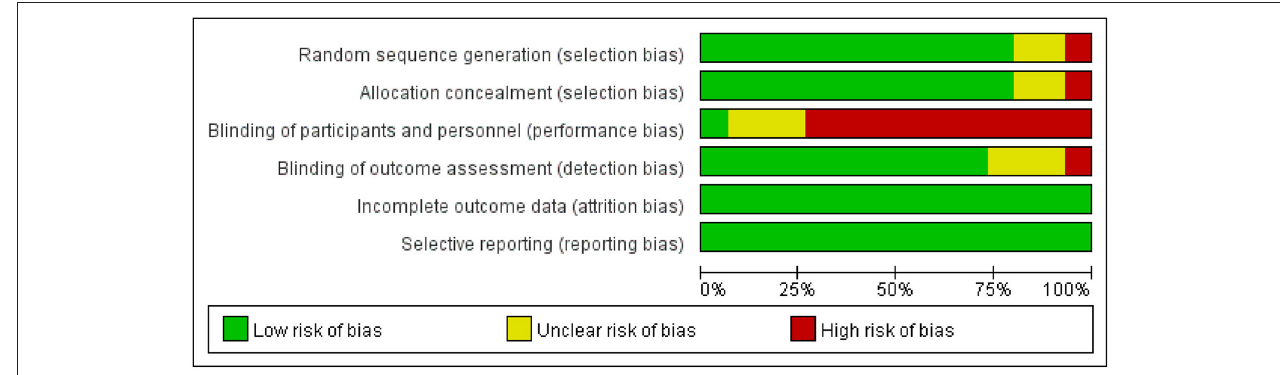
FIGURE 2 | Risk-of-bias chart for studies included in the quantitative analysis.